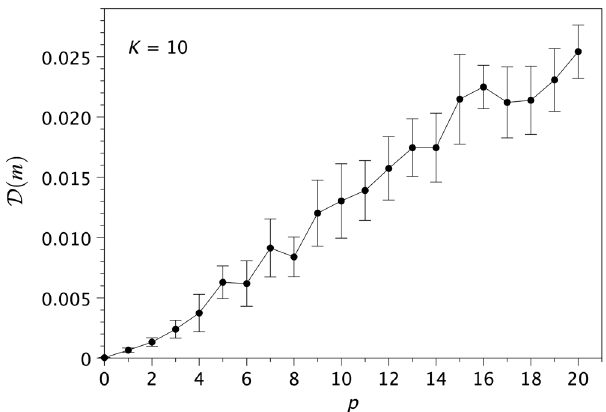
FIG. 14. Scenario 5b. Detectability measure D ð 3 Þ for a two- layer multiplex with K ¼ 10 nodes per layer, where the second layer is a replica of the first layer in which a number of shortcuts p have been introduced. Results have been averaged over 10 network realizations for each case.